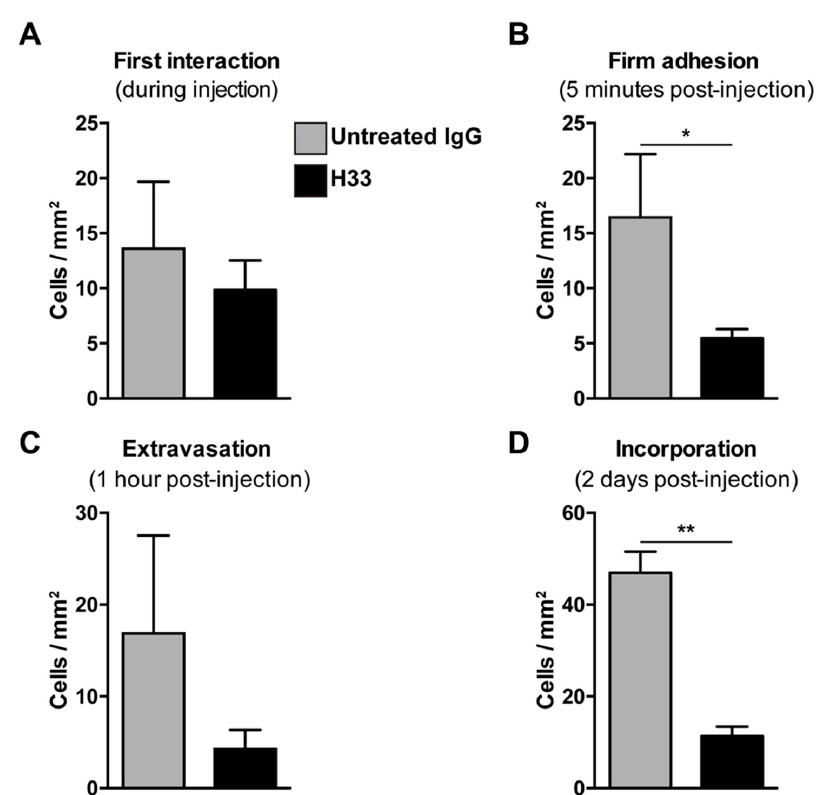
Figure 5. Blocking JAM-C via monoclonal antibody: Effect of e-EPC homing to tumor angiogenesis in vivo. C57BL/6 mice bearing LLC tumors in dorsal skin-fold chambers were pre-injected with Isotype control antibody 9B5 ( n = 2) or anti JAM-C H33 ( n = 4). After 20 min, DiI pre-labeled e-EPCs were intra-arterially injected into each group of mice and their recruitment to the tumor microvessels was analyzed by epi-fluorescent intravital video-microscopy. Microscopy and video analysis of cell interactions were performed at different time points: t0 = injection/first interaction ( A ); t1 = 5 min/firm adhesion ( B ); t2 = 1 h/extravasation ( C ), t3 = 2 days/long term recruitment ( D ), showing that JAM-C